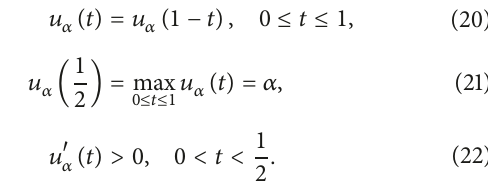
Figure 3: The graph of 𝜆(𝛼) for 𝑘 = 1 , 𝑛 = 2 .